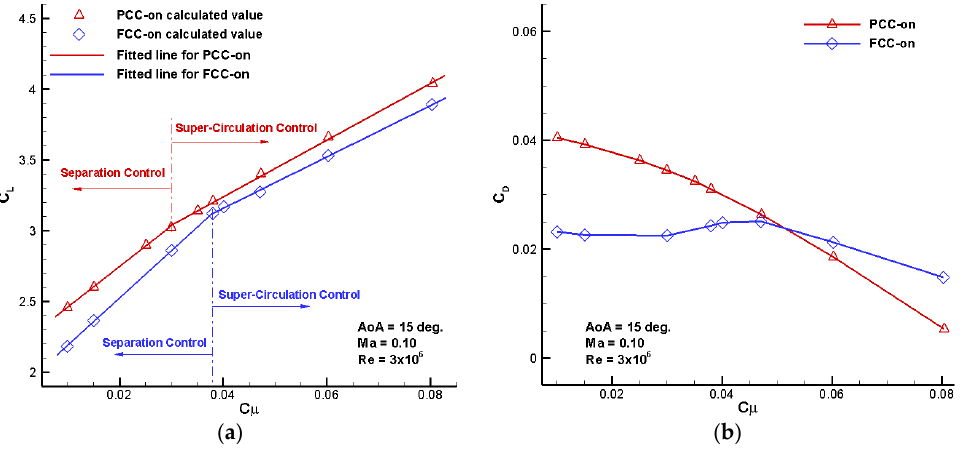
Figure 13. Variation of force coefficients versus jet momentum coefficient: ( a ) Lift coefficient; ( b ) Drag coefficient.